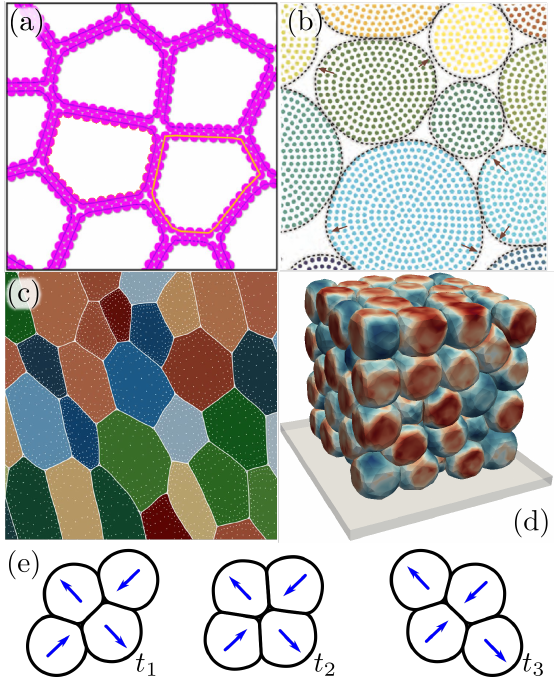
Figure 2: (a to d) Modeling squishy particle assem- bly: (a) using the “Deformable-Particle” (DP) method, a class of BPM-like method (with permission of C. O’Hern et al. [20]), (b) using the meshless approach MPM (with permission of S. Nezamabadi et al. [41]), (c) using the meshless “soft-DEM” approach (with per- mission of G. Mollon [64]), (d) using the 3D Non- Smooth Contact Dynamics approach by M. Cardenas- Barrantes et al. [46]. (e) Example of a T1-event run- ning from time t 1 to t 3 . Particles react to shear load- ing by this peculiar rearrangement: particles in the ex- pansion direction split apart and permit the ones in the compression direction to get closer up to the point where they touch each